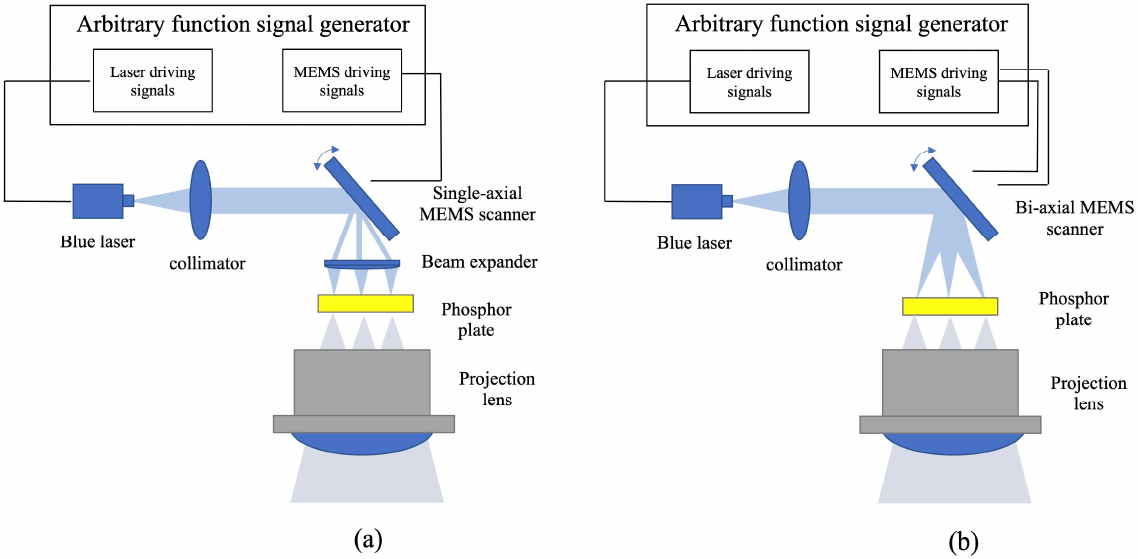
Figure 2. Flowchart of the laser headlight prototype based on ( a ) 1D MEMS laser beam scanning and ( b ) 2D Lissajous MEMS laser beam scanning mode.